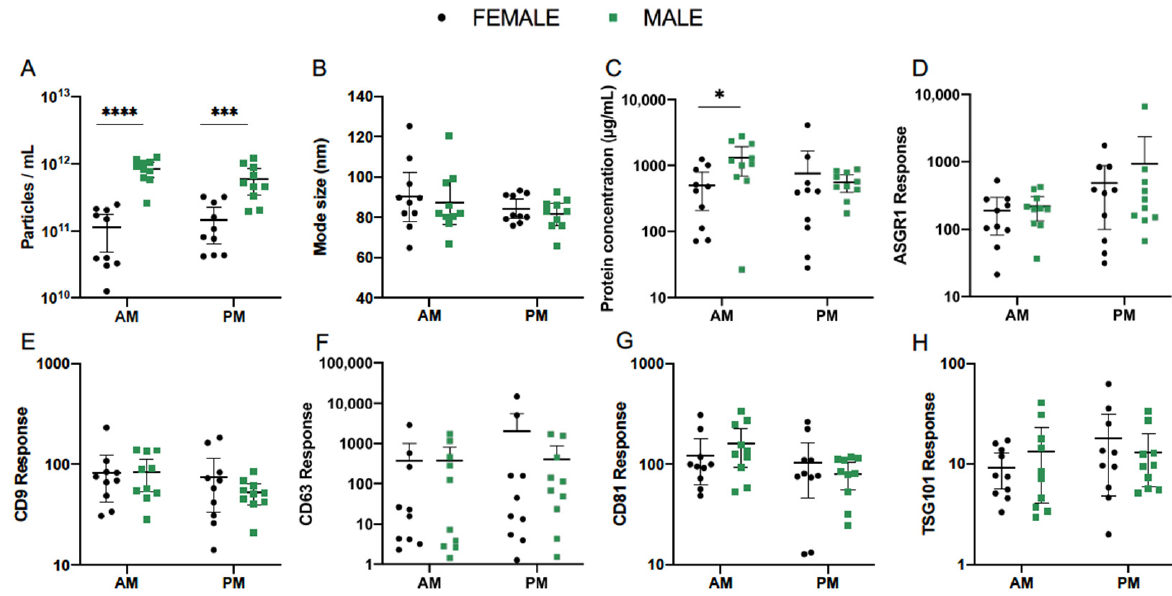
Figure 6. Effect of sex on serum EV particle abundance ( A ), size ( B ), total protein concentration ( C ), and expression of EV-associated protein markers ( D – H ), quantified by nanoparticle tracking analysis (NTA), microBCA assay, and liquid chromatography mass spectrometry (LCMS). Pooled analysis of EVs collected from serum of healthy female ( n = 10) and male ( n = 10) volunteers on study days 1 and 3. Statistical analysis performed using one-way ANOVA. * p ≤ 0.05, *** p ≤ 0.001, **** p ≤ 0.0001. Table 5. Pooled analysis of EVs collected from serum of healthy female ( n = 10) and male ( n = 10) volunteers on study days 1 and 3 in the morning and afternoon. Data presented as geometric mean and 95% confidence interval (CI) of particle count, mode size, total protein concentration, and EV- associated protein marker abundance. Statistical analysis performed using one-way ANOVA. ns: